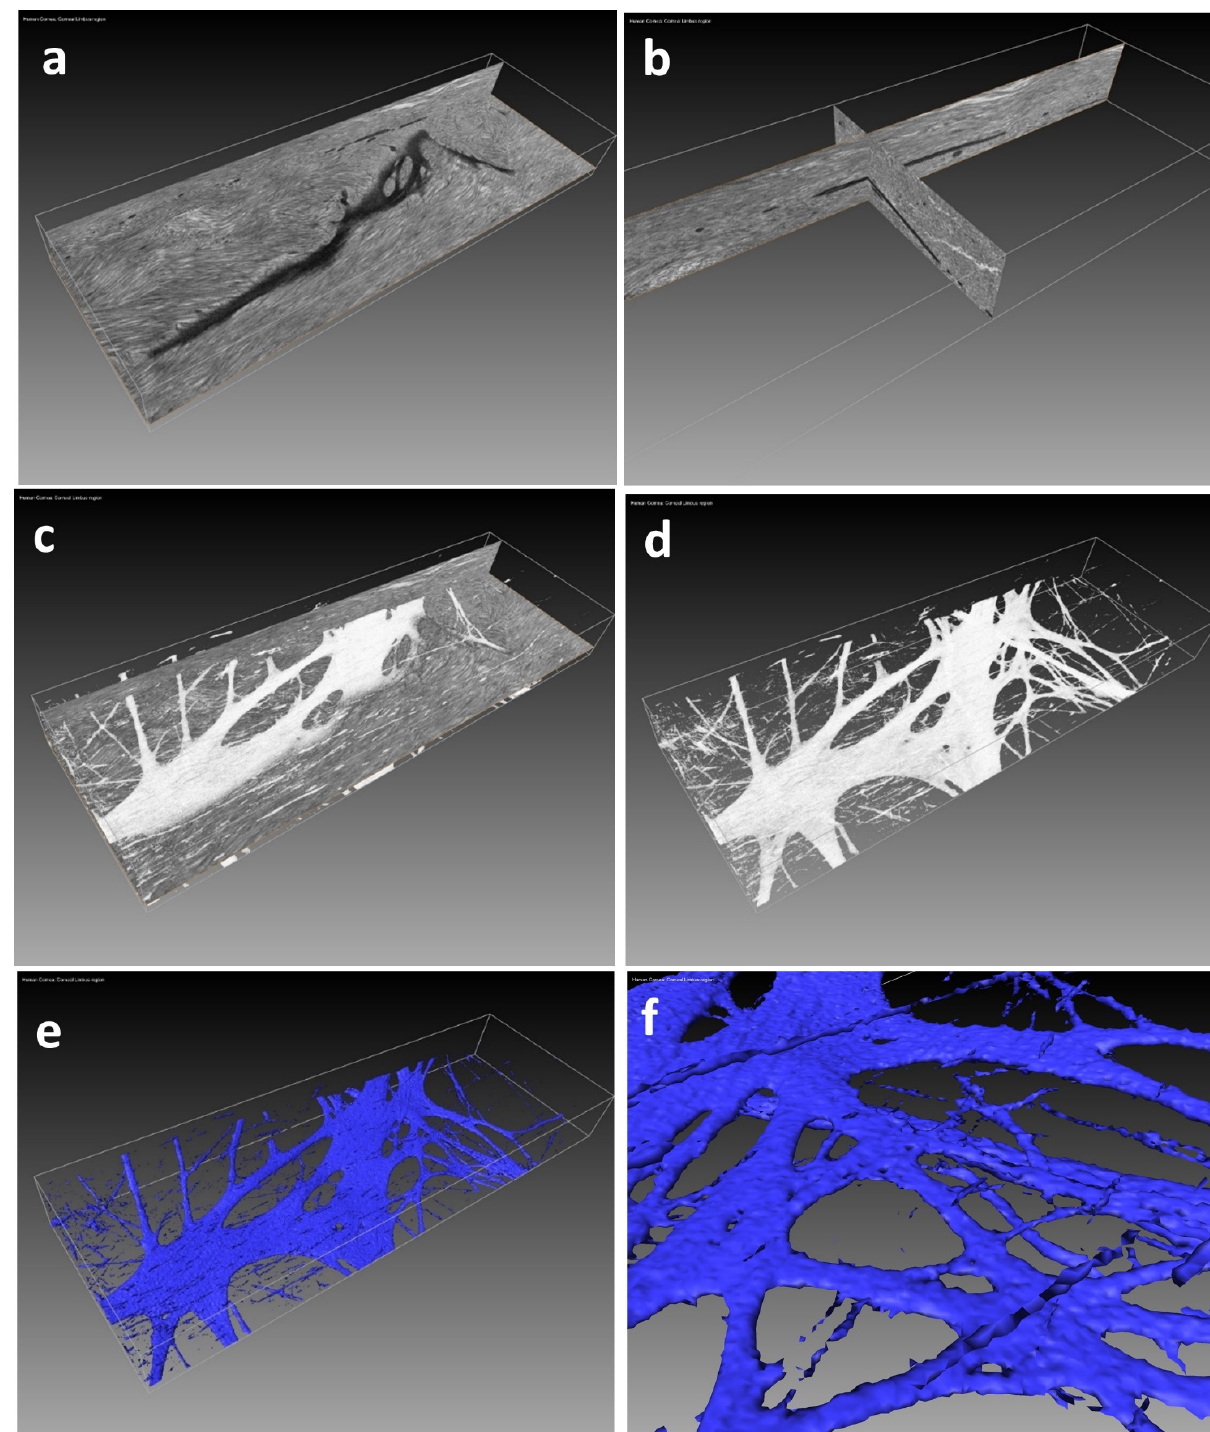
Figure 2. SBF SEM image data volume (45 × 20 × 10 microns) generated from human corneal limbus. The limbal region is characterized by an extracellular matrix (ECM) composed of hybrid type I and V collagen fibrils and sheets of fibrillin-rich elastic fibres. ( a ) demonstrates a dark intensely stained single fibrillin-rich elastic sheet, set within a light grey-stained ECM. ( b ) highlights how the dark intensely stained structure of the sheet is clearly seen within the x, y and z section planes of the 3D volume. ( c ) was obtained using the Amira Volren semi-automated rendering tool; the staining differential between the fibrillin-rich sheet and ECM is sufficient to render the sheet in 3D, shown in white. ( d ) reveals the 3D structure of the sheet with surrounding ECM removed. ( e ) was obtained utilizing Amira Isosurface; a solid surface (coloured blue) is applied to the sheet. ( f ) reveals the finer surface detail of the